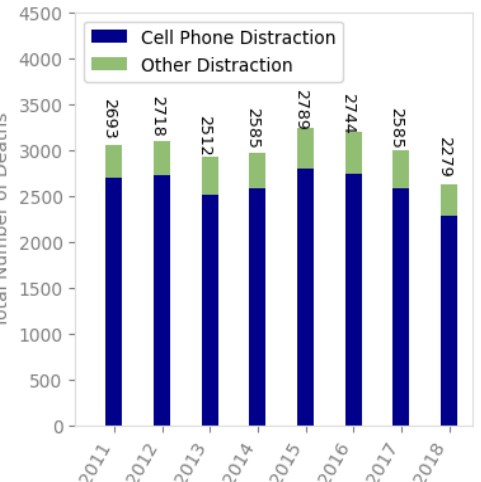
Figure 2. NHTSA data showing the percentage distribution of deaths due to distraction-affected crashes from 2011 to 2018 in the